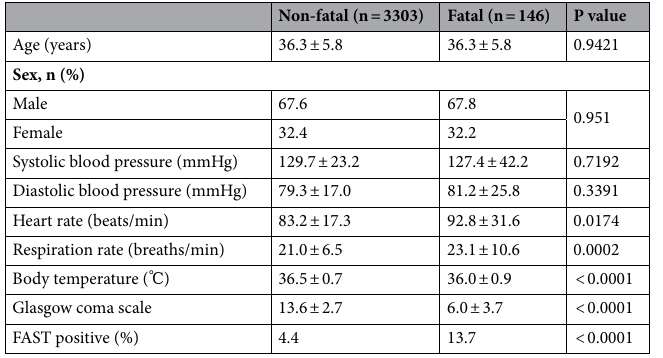
Table 1. Patient characteristics and data upon hospital arrival for adults (26–45 years) in the fatal and non- fatal groups (2004–2019). FAST focused assessment with sonography for trauma. Student’s t-test was used for values with a normal distribution, while the Wilcoxon test was used for values with a non-normal